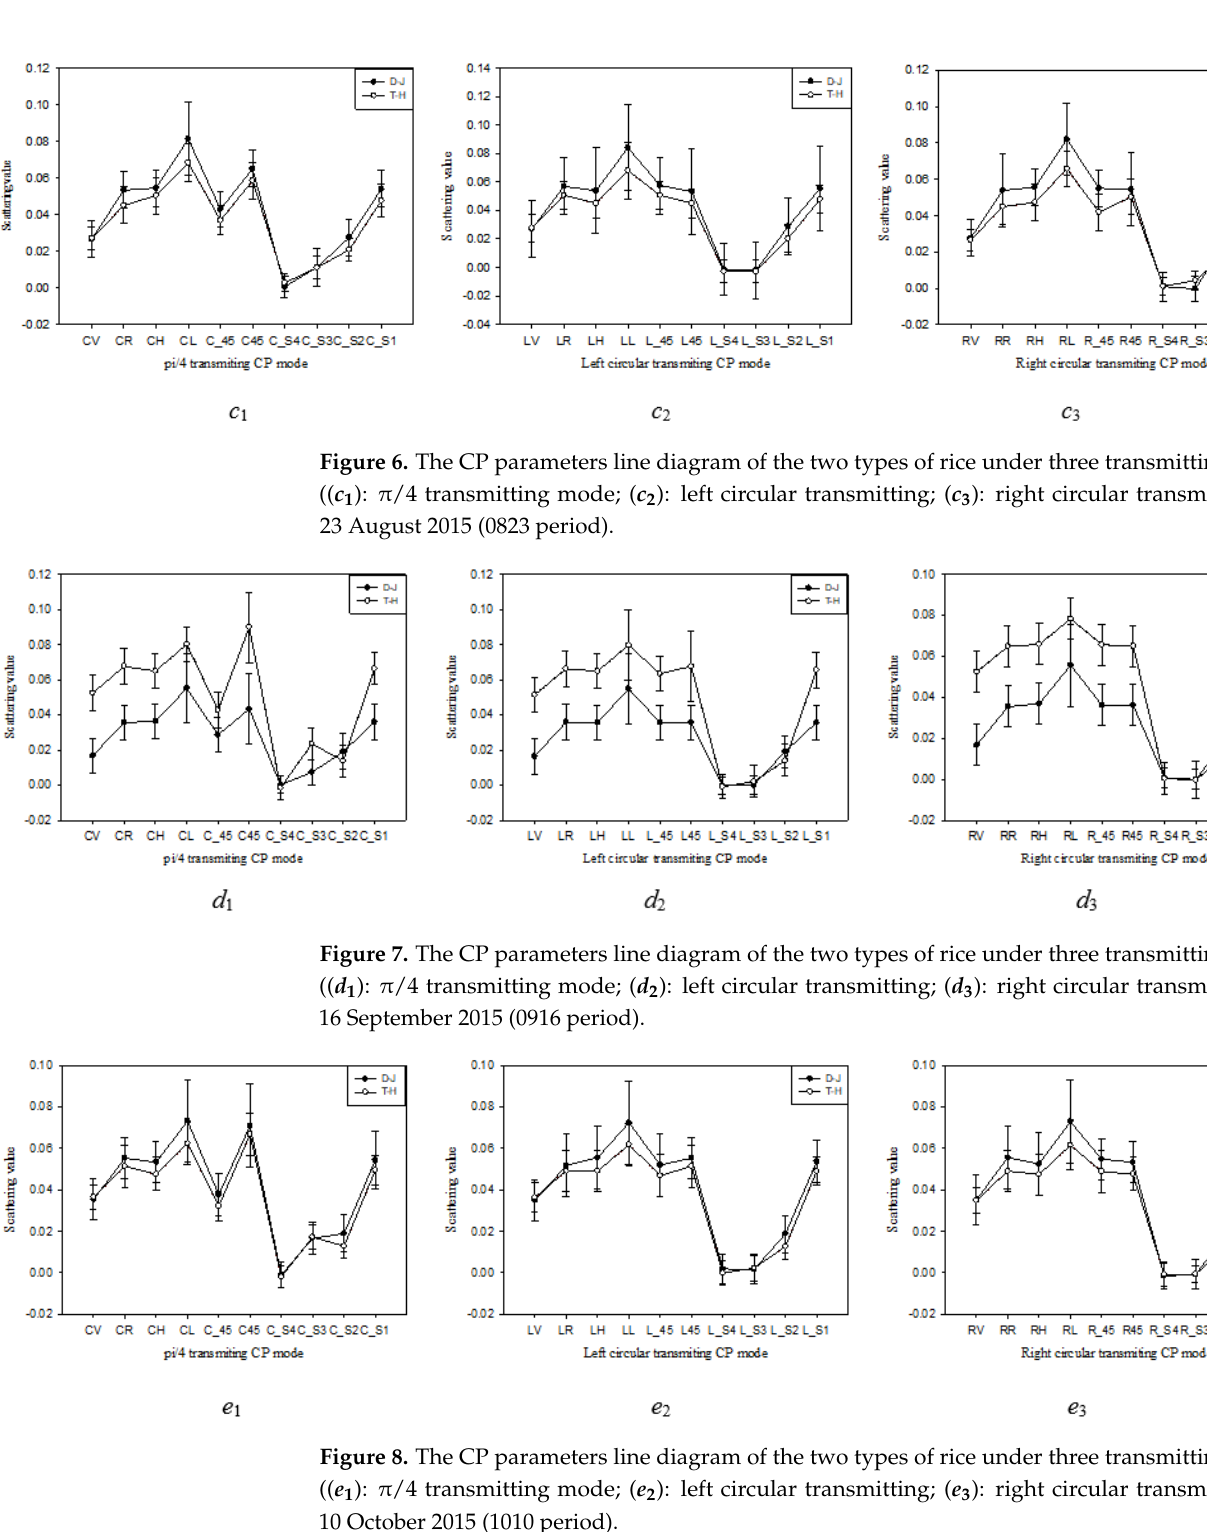
(( b 1 ): π /4 transmitting mode; ( b 2 ): left circular transmitting; ( b 3 ): right circular transmitting) on 30